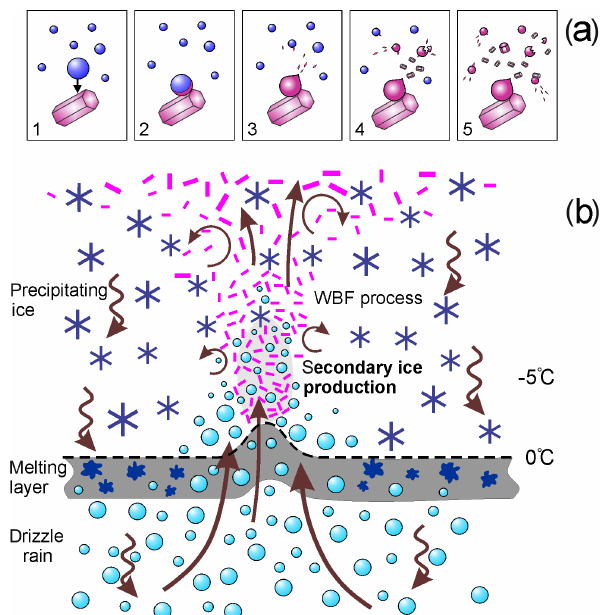
Figure 25. (a) Conceptual model of secondary ice production due to shattering of freezing drops. (b) Conceptual model of the effect of melting layer on the secondary ice particle formation in MCSs and frontal